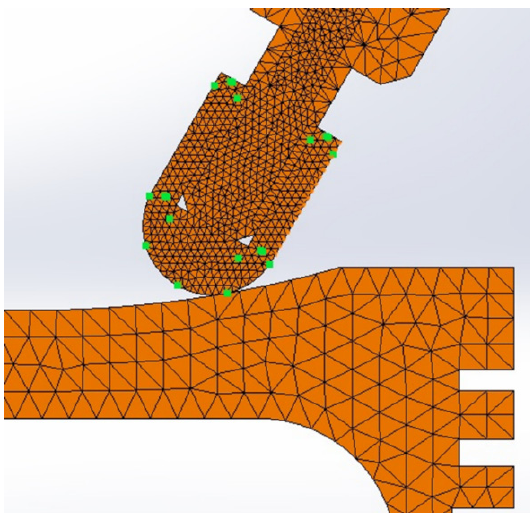
Figure 15. Mesh of parabolic tetrahedral solid elements The calculation results in the Solid Works Simu– lation application are shown in Fig. 16.